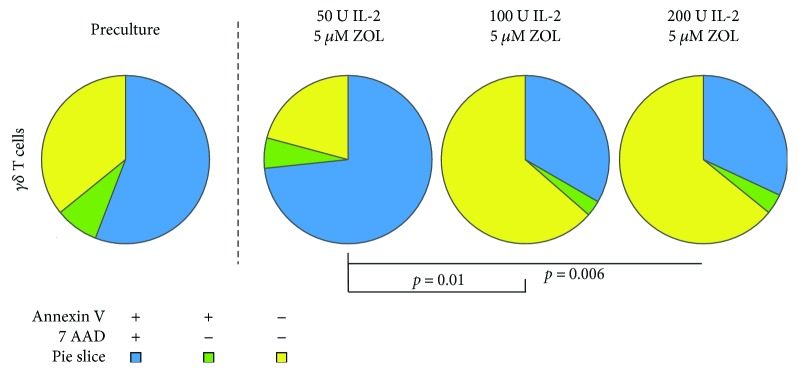
Cell death and apoptosis. Viability and apoptosis. The mean proportion of viable (annexin V− 7AAD−) cells, apoptotic (annexin V+ 7AAD−) cells, and dead (annexin V+ 7AAD+) cells are displayed and analyzed using the SPICE software. Statistical comparisons were performed using the built-in statistical analysis in the SPICE software. IL-2: interleukin 2; ZOL: zoledronate.